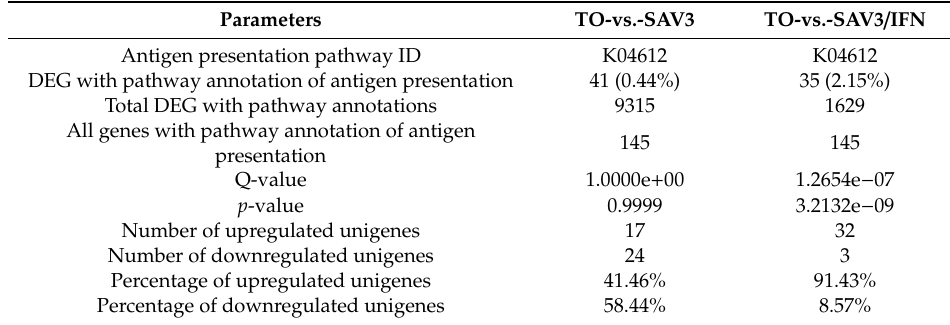
Table 2. Kyoto Encyclopedia of Genes and Genomes (KEGG) pathway analysis of antigen